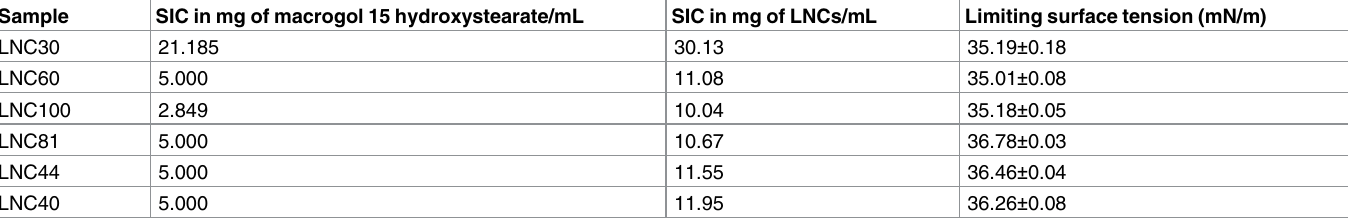
Table 4. Saturated interfacial concentration (SIC) and limiting surfacetension of the LNC formulations determined by the Wilhelmy plate method. The SIC is the concentration at which a sharp change in the slope has occurred. The limitingsurface tension is the lowest surface tensionobservedfor a given system regardlessof the bulk